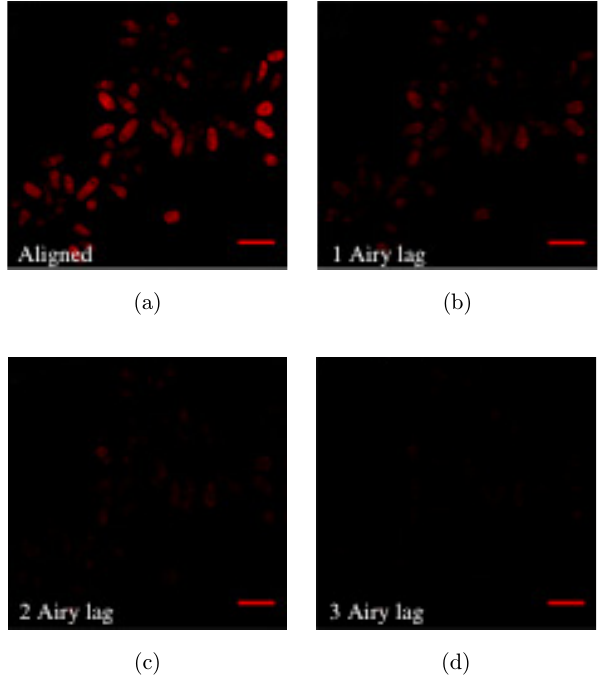
Fig. 7. Two-photon laser scanning confocal images of Ru nanoparticle-electroporated S. pombe acquired by using (a) the optically-aligned excitation beam, (b) – (d) the pinhole shift giving displacement by 1, 2 or 3 Airy units, respectively. Scale bars ¼ 10 (cid:1) m Reproduced with permission from Williams